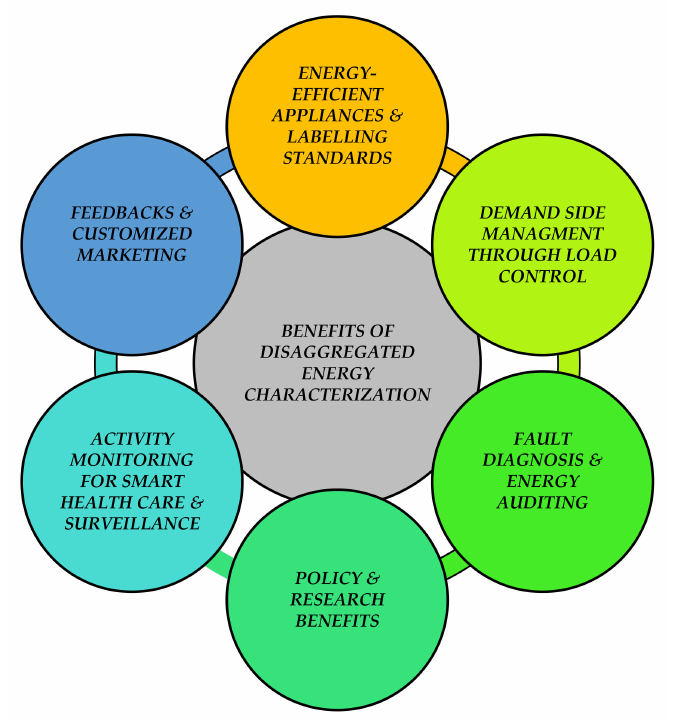
Figure 1. Benefits of disaggregated energy characterization in smart cities.